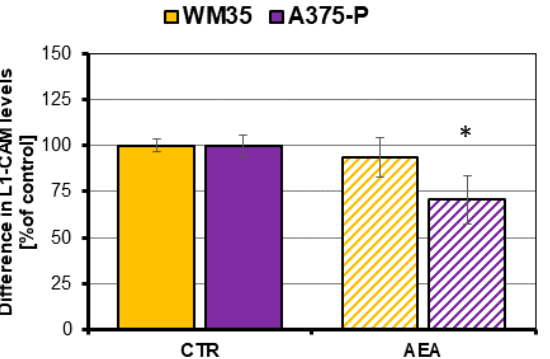
Figure 4. Difference in the L1-CAM glycoprotein production by AEA-treated melanoma cells. The investigated cell lines are from the following stages of melanoma progression: RGP site (WM35) and from the solid tumor site (A375-P). The statistical significance of the p -value below 0.05 (*) was marked on the